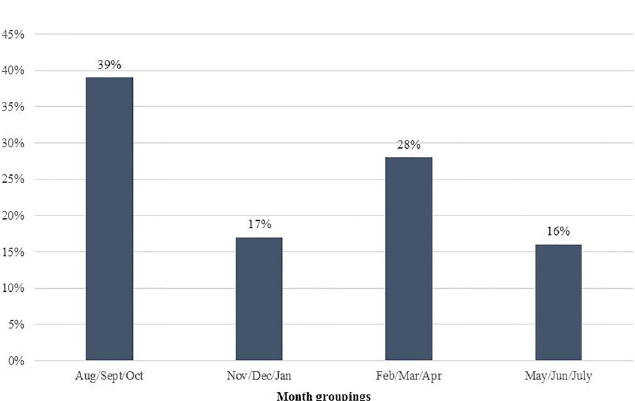
Figure 3. Percentage of sexual assault cases presenting to the ED by month groupings among emerging adults.